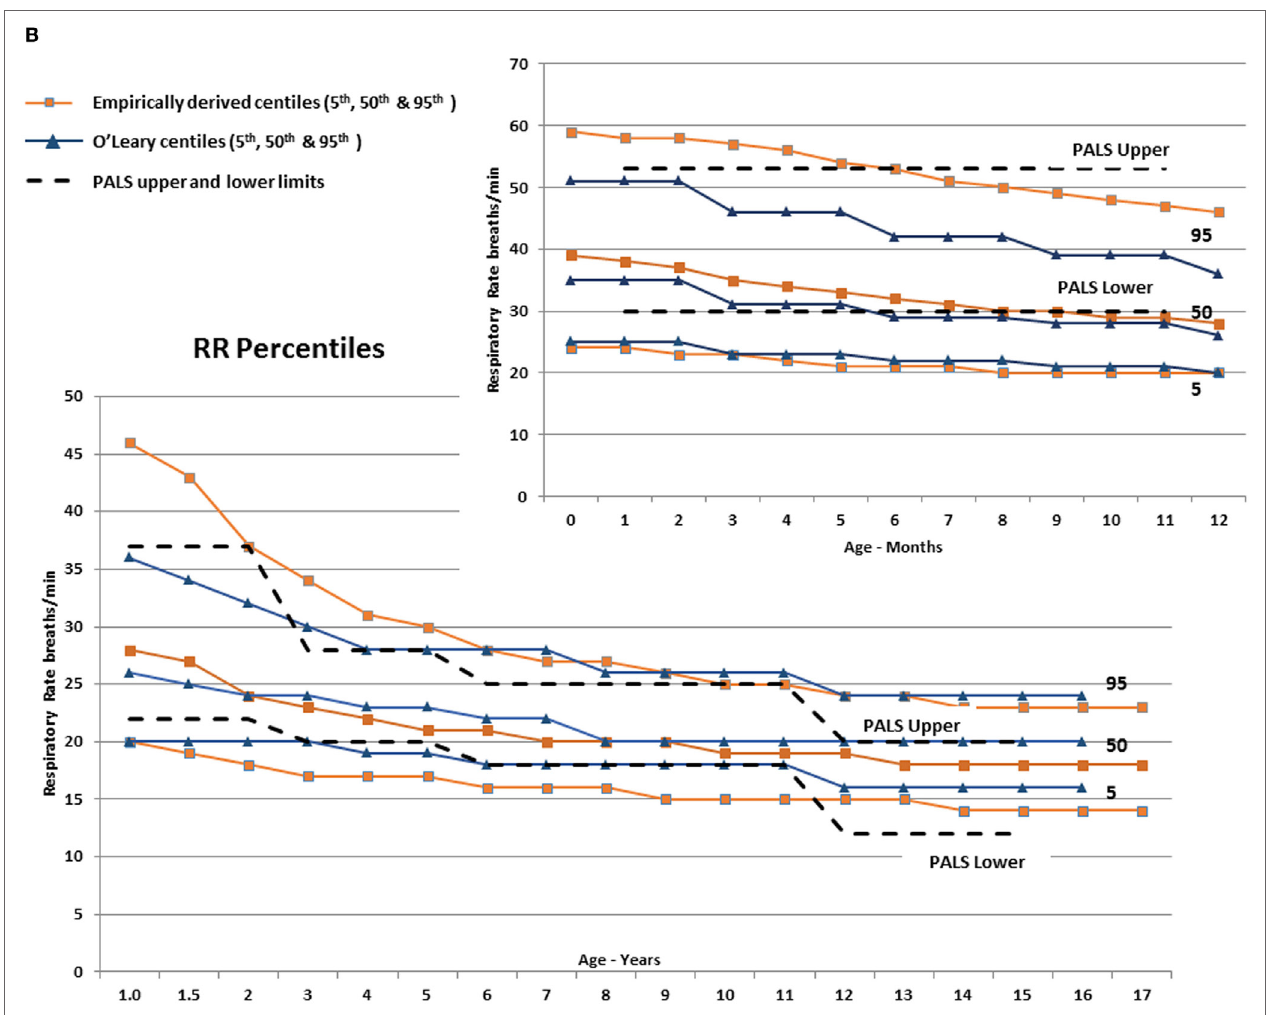
FigUre 3 | (a) The derived 5th, 50th, and 95th HR centiles by age compared with similar centiles derived by O’Leary et al. (10) The Pediatric Advanced Life Support (PALS) (29) upper and lower HR limits are also shown (dashed lines). The smaller panel shows the centiles from 0 to 12 months of age. (B) The derived 5th, 50th, and 95th RR centiles by age compared with similar centiles derived by O’Leary et al. (10). The PALS (29) upper and lower RR limits are also shown (dashed lines). The smaller panel shows the centiles from 0 to 12 months of